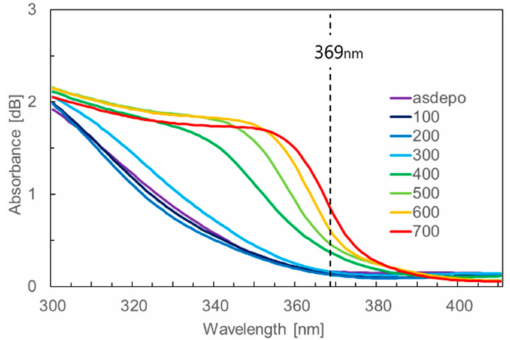
Figure 9. Absorbance spectra of the fabricated Al:ZnO at various annealing temperatures.